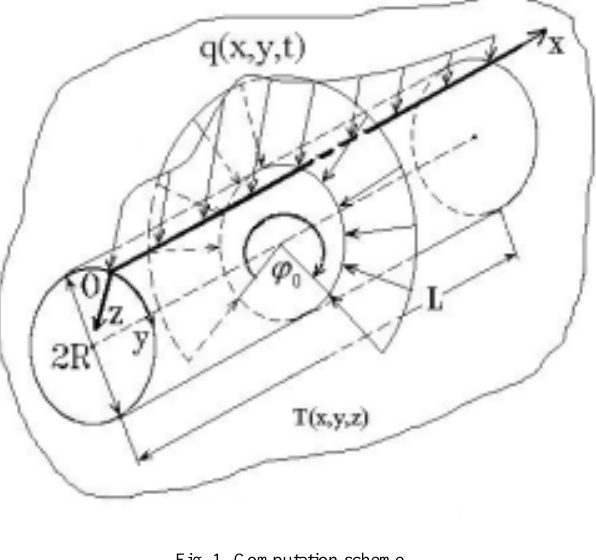
Fig. 1. Computation